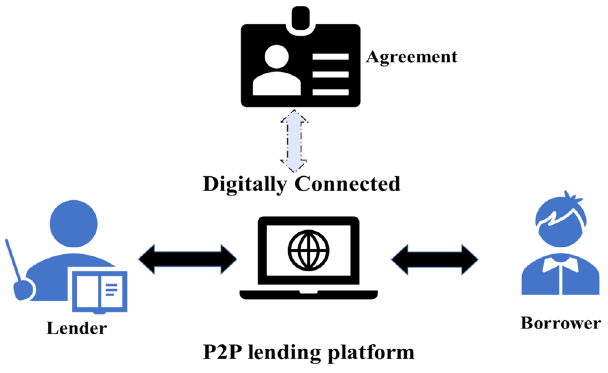
Figure 1: Basic P2P lending